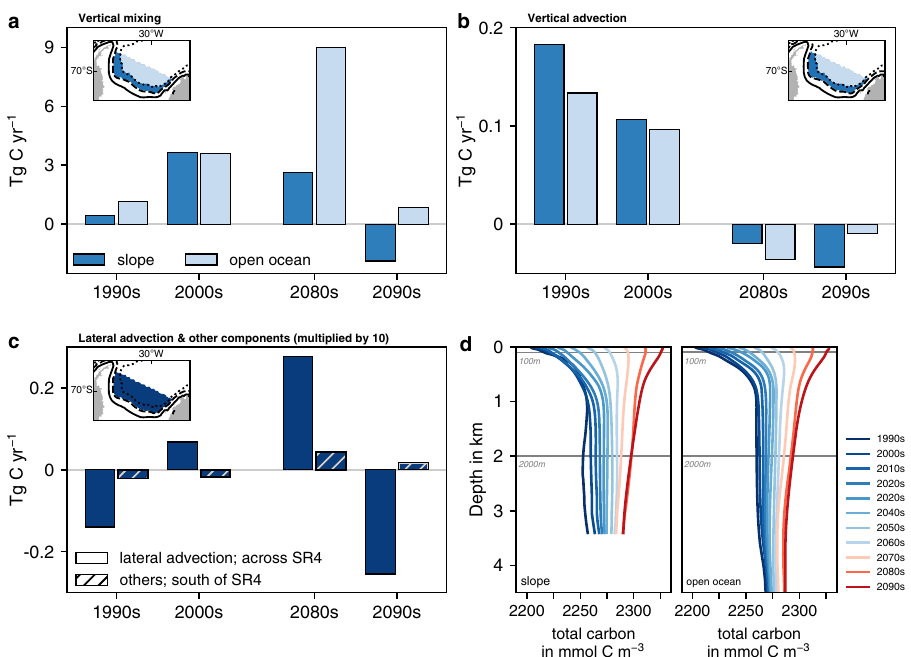
Fig. 3 Divergence of physical fl ux components contributing to changes in the deep-ocean carbon inventory. Changes in the total carbon inventory south of the transect SR4 and below 2000 m in the model simulation simA (historical + SSP5-8.5 scenario) in the 1990s, 2000s, 2080s, and 2090s due to a vertical mixing across 2000 m, b vertical advection across 2000 m, and c lateral advection across the transect SR4 and the sum of all other fl ux components, e.g., from the eddy parametrization (dashed bars). Positive fl uxes denote an increase in the inventory in the volume of interest due to the respective fl ux component. All fl uxes are in Tg C yr − 1 , but note that the fl uxes in c are one order of magnitude smaller than those in a , b . d Shows vertical pro fi les of total carbon concentrations in mmol m − 3 averaged over each decade from 1990 – 2100 in simA . Pro fi les are colored as a function of time in shades of blue and red depending on whether concentrations at 100 m are lower (blue) or higher (red) than those at 2000 m, respectively. Vertical fl uxes in a , b and vertical pro fi les in d are shown for the continental slope and the open ocean, which are separated at the 3500 m isobath (see inlet in a , b